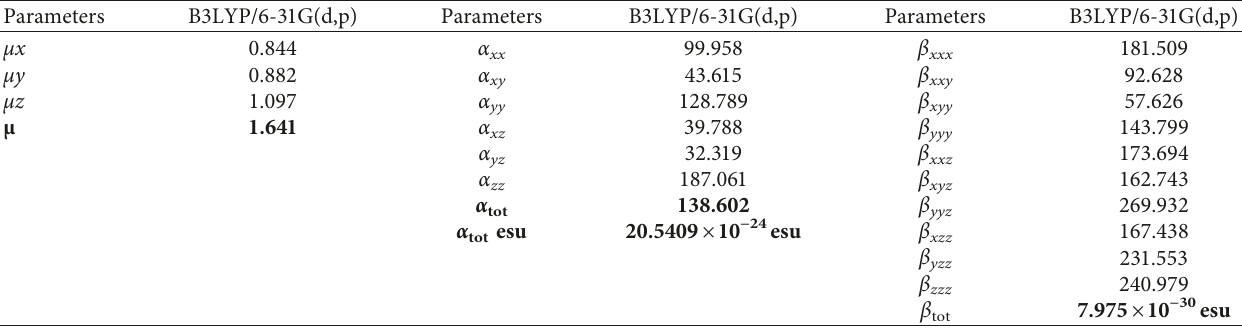
Figure 15: TG/DTA curves of BDSC. Table 7: Based on DFT calculations using the 6-31+G(d,p) basis set, values for the BDSC dipole moment, polarizability, and first-order hyperpolarizability were